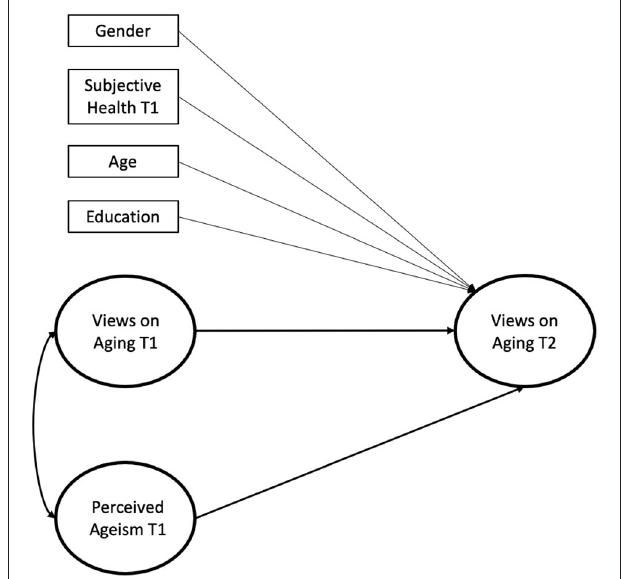
FIGURE 1 | Structural equation model with covariates predicting views on aging at the second measurement occasion by perceived ageism at the first measurement occasion. For reasons of parsimony, bivariate correlations between covariates and latent variables are omitted from the figure. Corresponding factor loadings for the AgeCog scales were constrained to be equal across timepoints and error variances for the same manifest indicators were allowed to covary across time. T1, Timepoint 1; T2, Timepoint